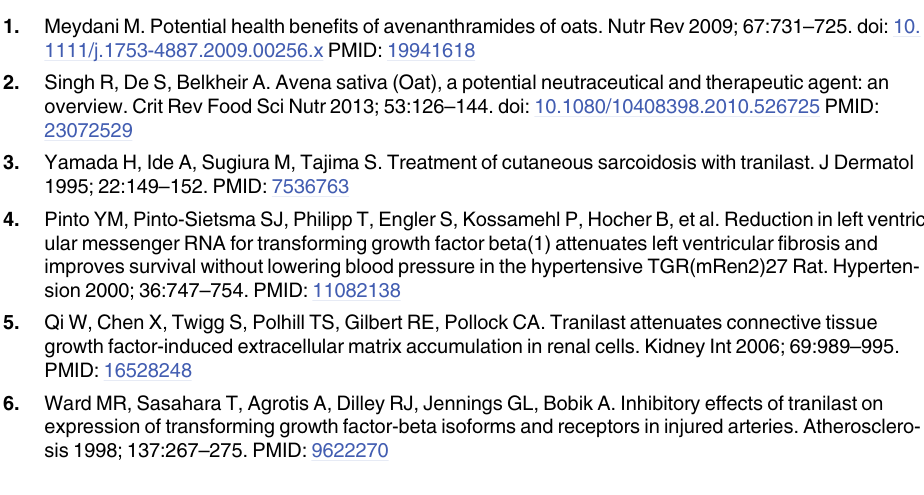
recombinant 4CL5-HCBT yeast strain. ESI-MS spectra were obtained after LC-TOF MS anal- ysis of the culture medium of the yeast strain fed with the precursors indicated in Table 2. S3 Fig. LC-MS elution profiles of 84 benzoyl anthranilates produced by the recombinant 4CL5-HCBT yeast strain. ESI-MS spectra were obtained after LC-TOF MS analysis of the cul- ture medium of the yeast strain fed with the precursors indicated in Table 3. S1 Table. Structures and concentrations of the cinnamates used for the yeast feedings. S2 Table. Structures and concentrations of the dihydrocinnamates used for the yeast feed- ings. S3 Table. Structures and concentrations of the benzoates used for the yeast